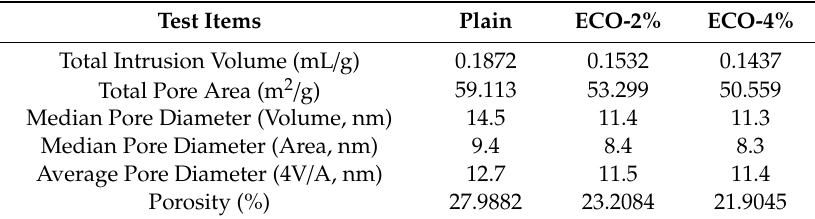
Table 8. Results of mercury intrusion porosimetry (MIP) tests.